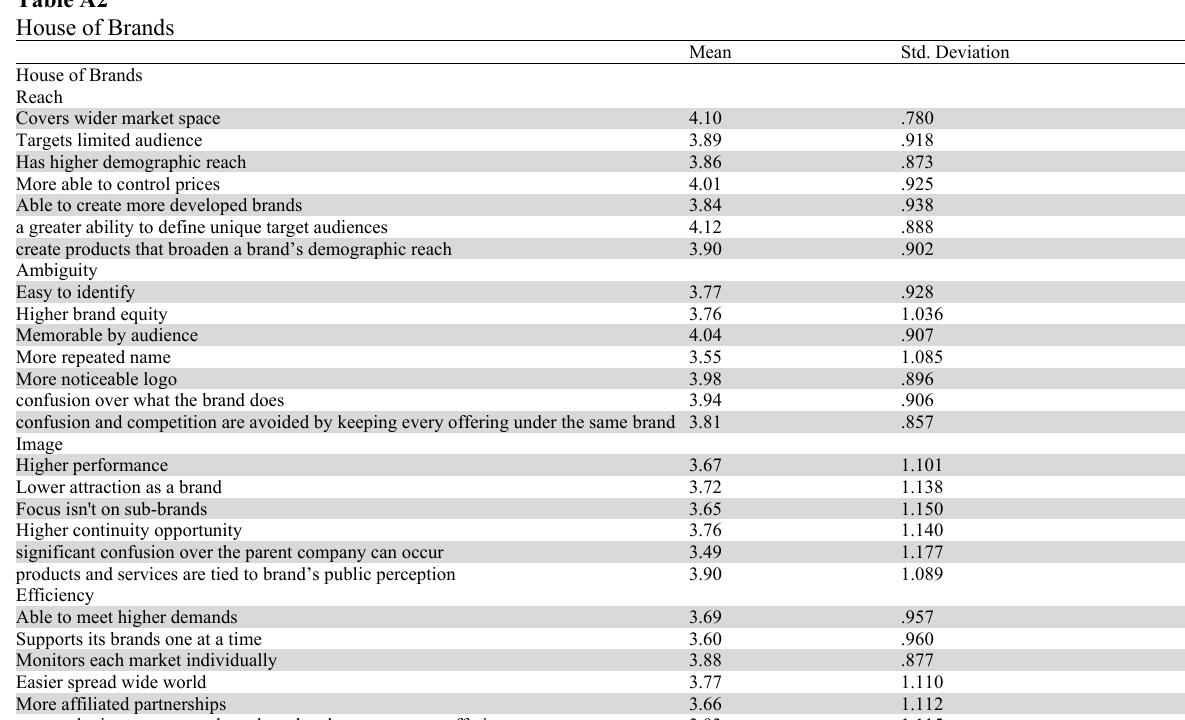
Mean Std. Deviation